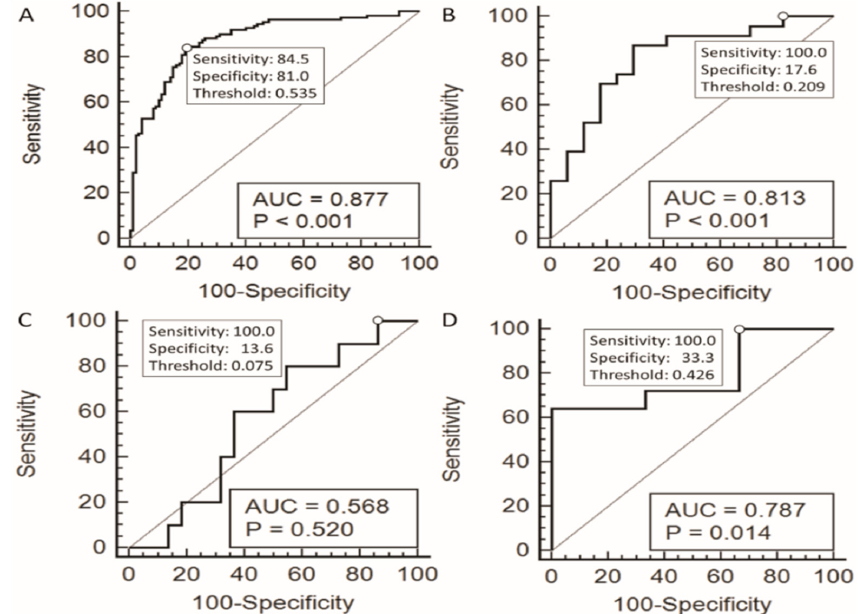
Figure 1. Receiver operating characteristic curves and their area under the curve (AUC), where